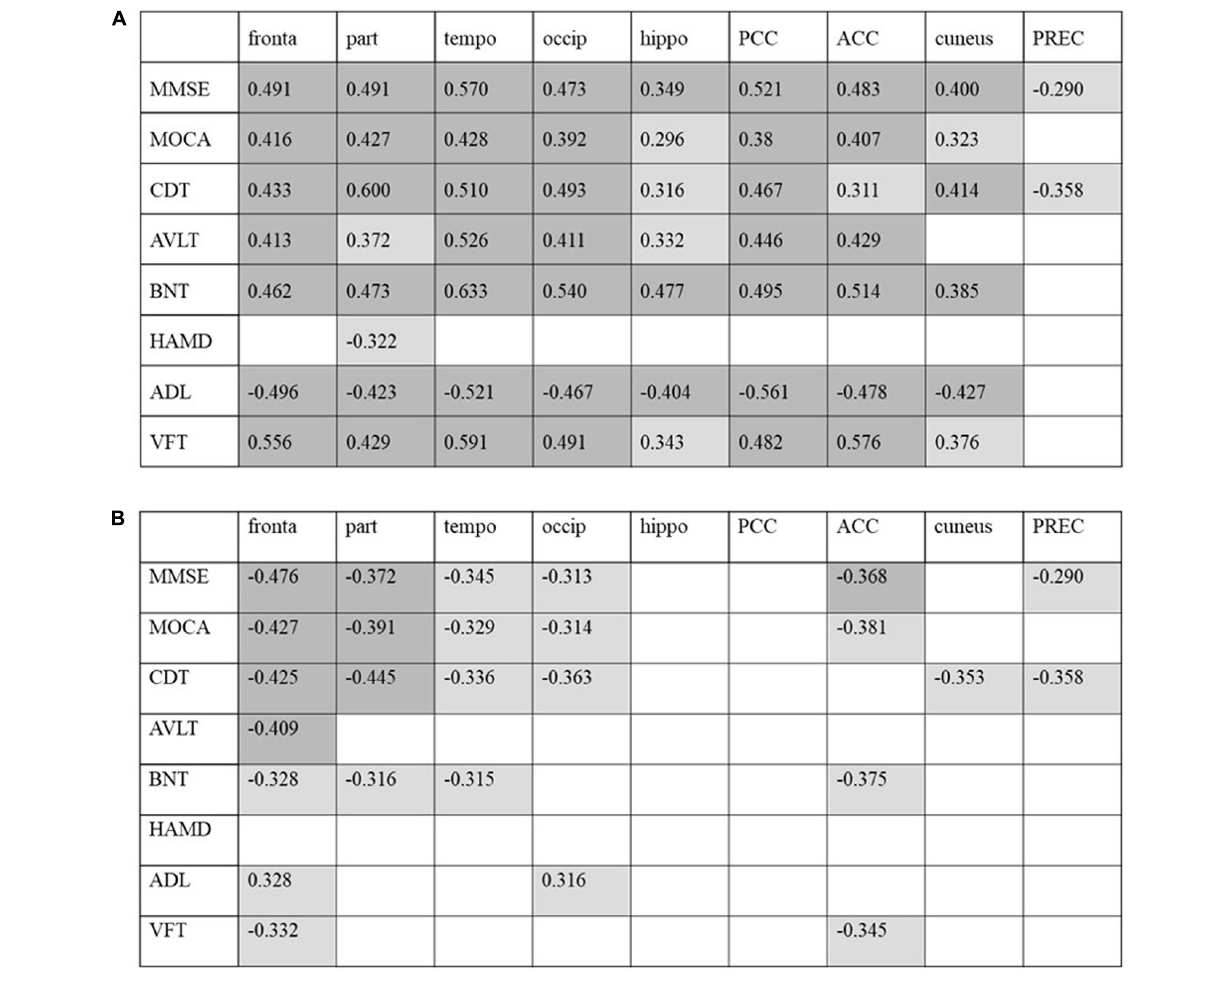
metabolism decrease is faster than that of tau protein